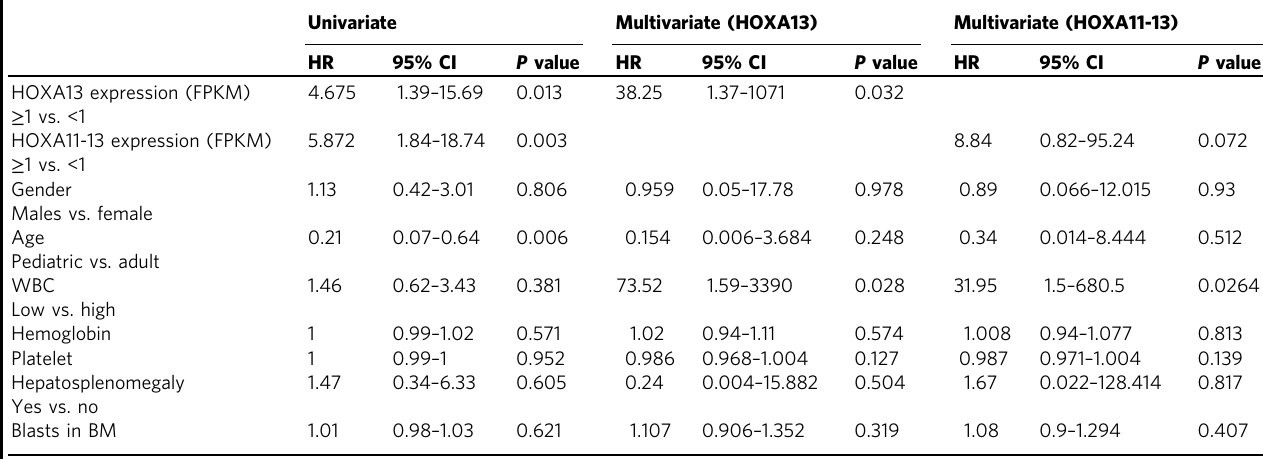
Table 1 Univariable and multivariable analysis of overall survival according to HOXA13 or HOXA11-13 expression and select